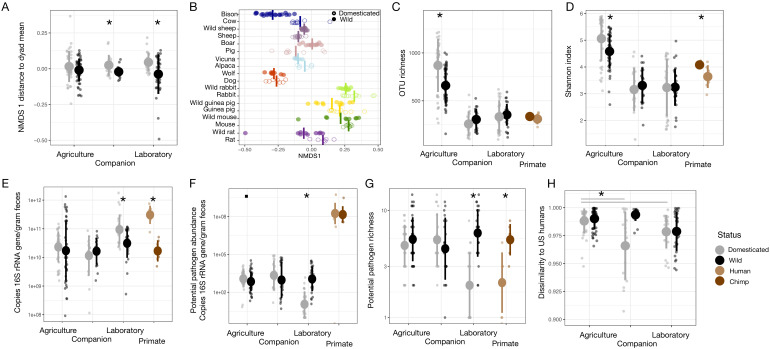
Microbial parameter comparisons between wild and domesticated mammals and between chimpanzees and humans.Bray–Curtis nonmetric multidimensional scaling (NMDS) ordination shifts for domestication groups (A) and dyads (B), OTU richness (C), Shannon index (D), bacterial density (E), potential human pathogen (see Kembel et al., 2012; Reese et al., 2016) abundance (F), and potential pathogen richness (G) varied by domestication status for at least one domestication type (agriculture, companion, or laboratory) in our cross-species dataset. Trends often mirrored those seen in comparing US humans to wild chimpanzees. Among domesticated animals, dissimilarity from US humans (H) was greater for agricultural animals than for companion or laboratory animals. However, among wild animals, dissimilarity from US humans did not differ by type. * indicates p<0.05, • indicates p<0.10, Mann–Whitney U test. Large circles are means; bars show standard deviations.